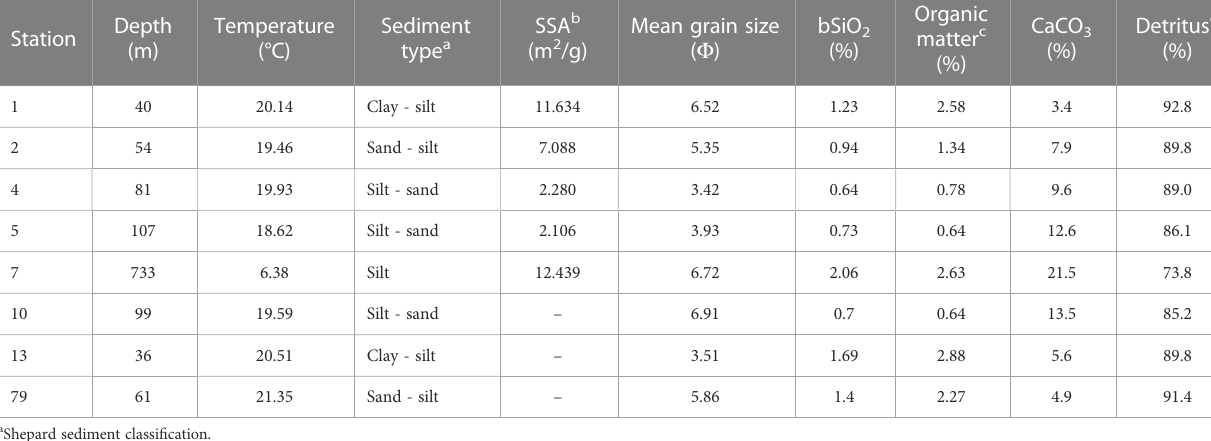
TABLE 1 Characterization of the sediment samples used for fl ow-through